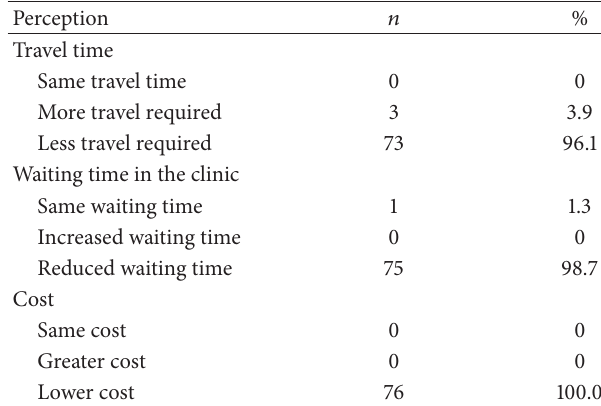
Table 3: Patients’ perception of the visit to the telecardiology clinic intermsoftraveltime,waitingtime,andcostascomparedtovisiting the specialist in the referral